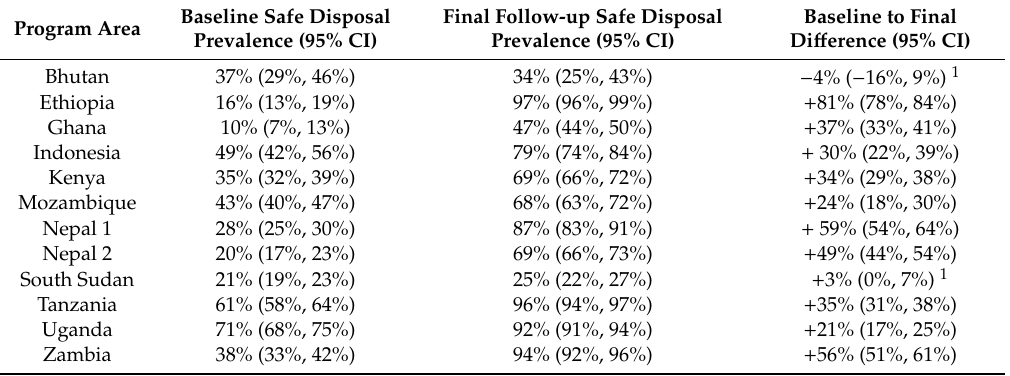
Table 4. Reported safe disposal of child feces, shown by program area (restricted to households with children < 3 years of